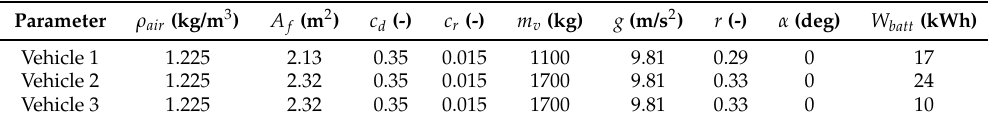
Table 3. Vehicle data for the three different vehicles used in the different case studies [10].